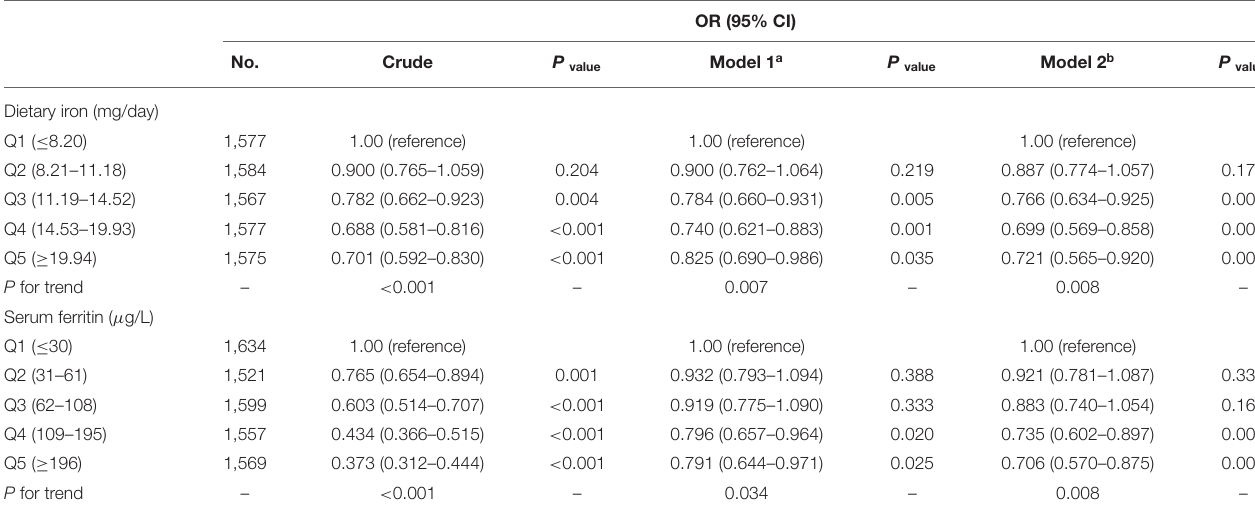
TABLE 3 | Association between dietary iron intake and serum ferritin and